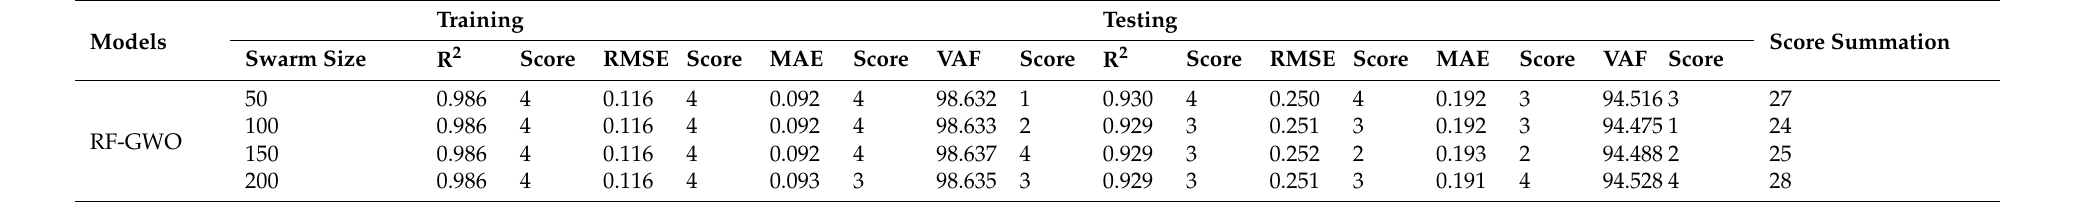
Table 4. Performance of different swarm sizes of the RF-GWO models on predicting the PPV.